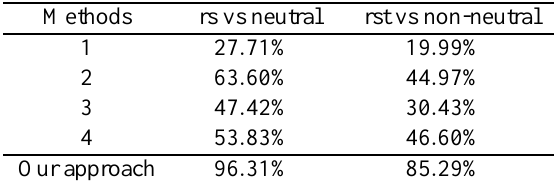
Table 3. Comparison of rank-one identification rates (between- class